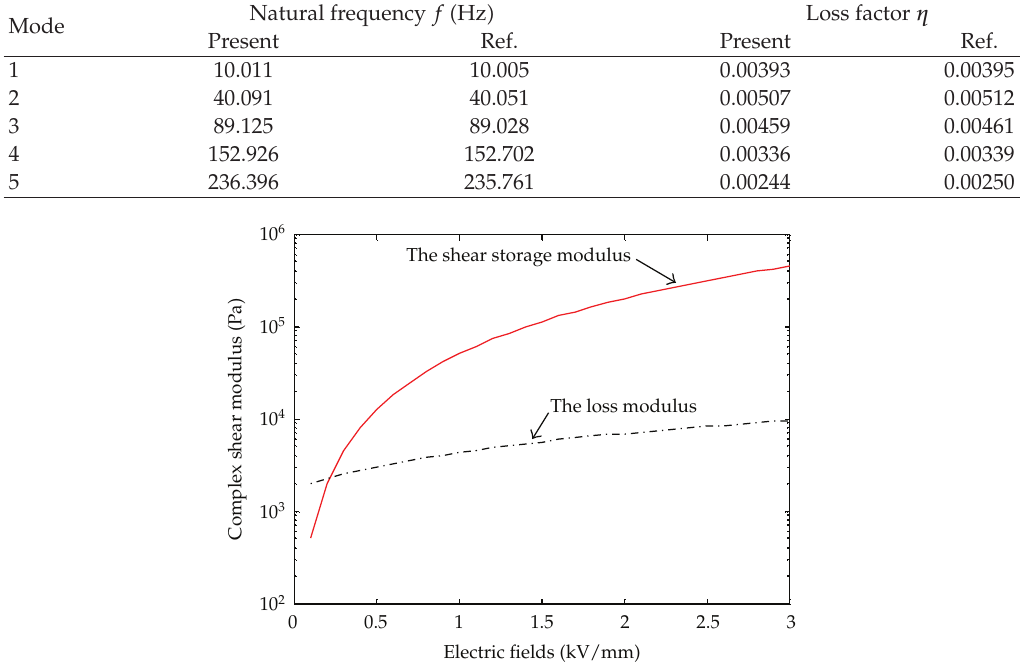
Figure 4: Complex shear modulus of ER fluids at di ff erent electric